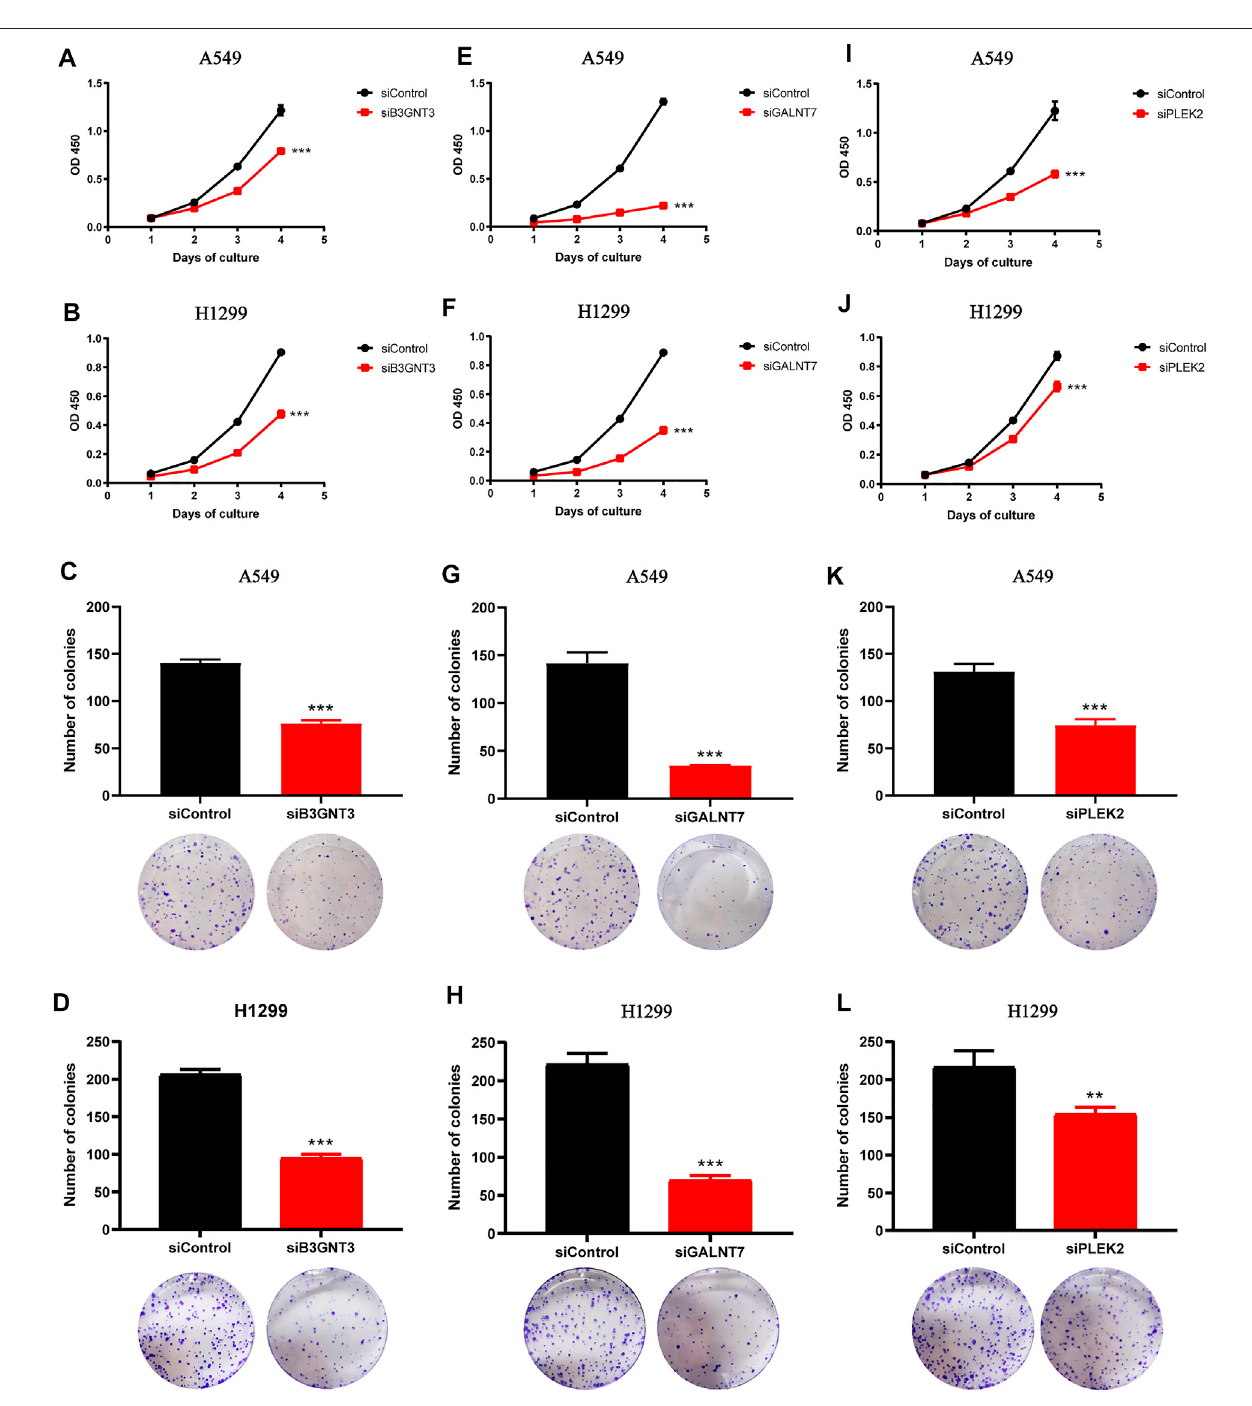
FIGURE 3 | Downregulation of B3GNT3, GALNT7, or PLEK2 suppresses tumorigenesis in lung cancer. (A – B) CCK-8 assay revealed that B3GNT3 silencing impaired cell proliferation in A549 (A) and H1299 (B) (n= 5). (C – D) B3GNT3 depletion signi fi cantly weakened colony-forming capacity ofA549 (C) and H1299 (D) (n =3). (E – H) GALNT7. (I – L) PLEK2. ** p < 0.01 and *** p < 0.001.